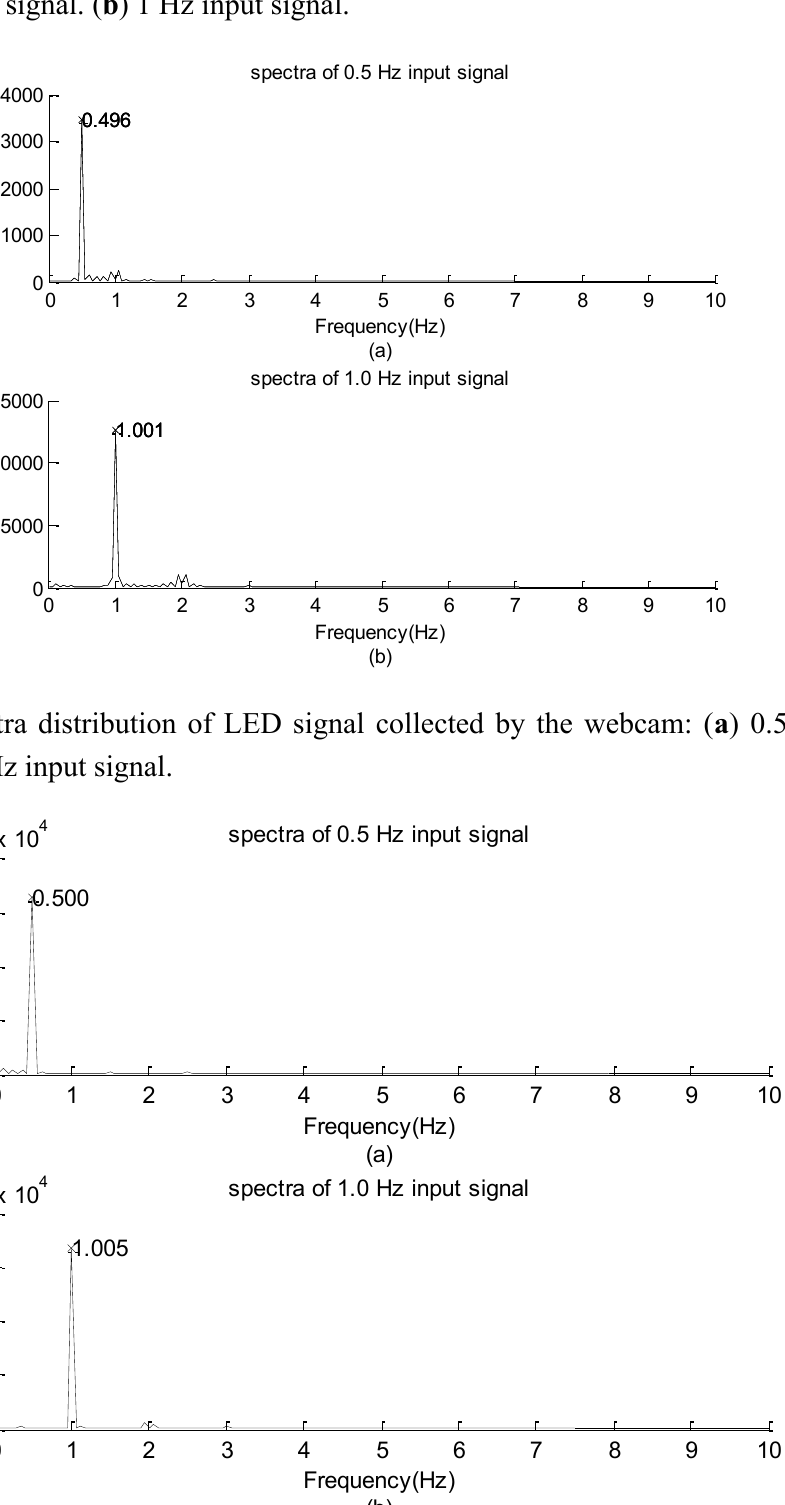
Figure 7. Spectra distribution of LED signal collected by the high speed camera: ( a ) 0.5 Hz input signal. ( b ) 1 Hz input signal.